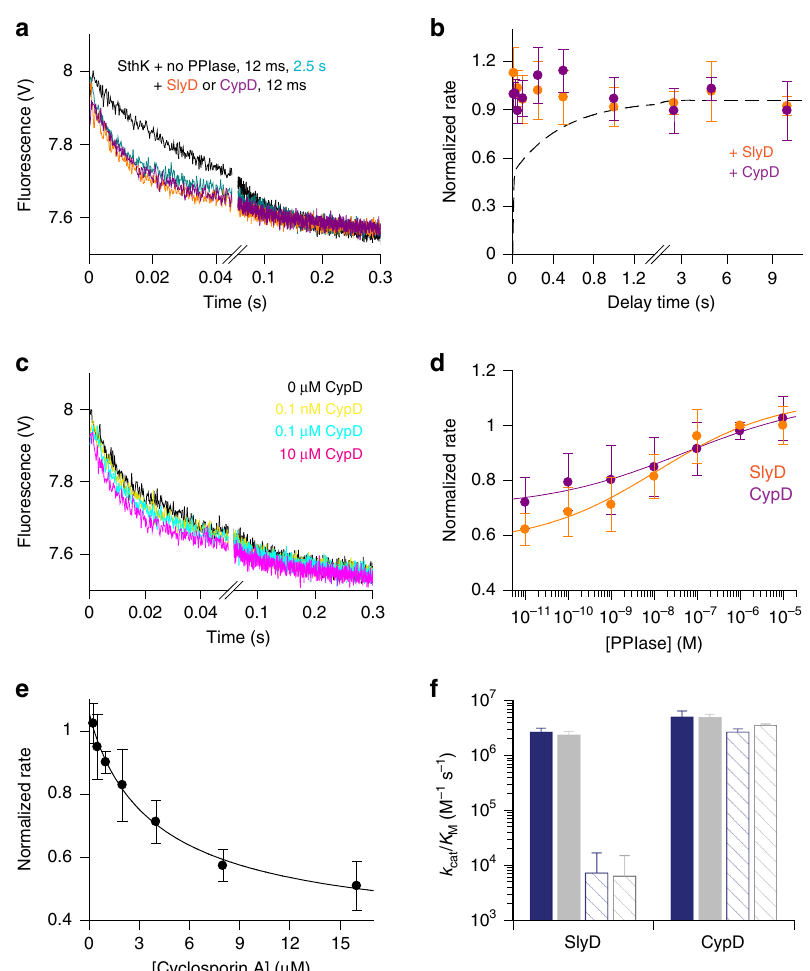
Fig. 2 Enzymatic activity of PPIases and their effect on SthK. a Quenching kinetics from the Tl + fl ux assay for WT SthK + 100 µ M cAMP after incubation for 12 ms (black) and 2.5 s (teal) and after 12 ms in the presence of 1 µ M CypD (purple) or 1 µ M SlyD (orange). b Rate constants (Eqs. (2) and (3)) obtained from kinetics as shown in ( a ) for WT SthK in the presence of 100 µ M cAMP and 1 µ M CypD (purple, n = 3 independent experiments) or 1 µ M SlyD (orange, n = 6 independent experiments). Dashed line represents the activation of SthK in the absence of PPIases, taken from Fig. 1f. c Quenching kinetics from the Tl + fl ux assay performed in the presence of different concentrations of CypD (0 M CypD — black, 10 − 10 M — yellow, 10 − 7 M — cyan, 10 − 5 M — pink). Kinetics were obtained after 12 ms incubation with 100 µ M cAMP. d Normalized rate constants (Eqs. (2) and (3)) from kinetics as shown in ( c ) for CypD (purple, n = 4 independent experiments) and SlyD (orange, n = 4 independent experiments). Data were analyzed using Eq. (4) yielding EC 50 values of ~30 nM. e Normalized rate of Tl + fl ux for SthK after activation by 100 µ M cAMP for 12 ms in the presence of 1 µ M CypD and increasing concentrations of CsA ( n = 3 independent experiments). Data were fi tted to Eq. (5) giving IC 50 = 4 ± 1.6 µ M, s = 0.9 ± 0.2. f Catalytic activities k cat / K M of SlyD and CypD from a peptide-based isomerization assay. Values, plotted as bars, are obtained from fi ts of data points as shown in Supplementary Fig. 3b for the substrates Abz- ALPF-pNa ( fi lled bars) and Abz-AEPF-pNa (hatched bars). The assays were performed in 20 mM Hepes, 100 mM KCl, pH 7.4 (gray) and 10 mM Hepes, 140 mM KNO 3 , pH 7.4 (navy). Numerical values together with the S.E. of fi ts are also in Supplementary Table 1. Symbols in ( b , d , e ) are mean ± S.D., in ( f ) fi tted values ± S.E. of fi ts. Source data are provided as a Source Data fi